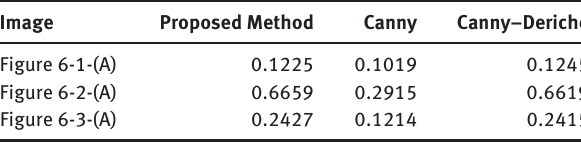
Table 3. FOM Values for Both the Proposed and the Canny Method.